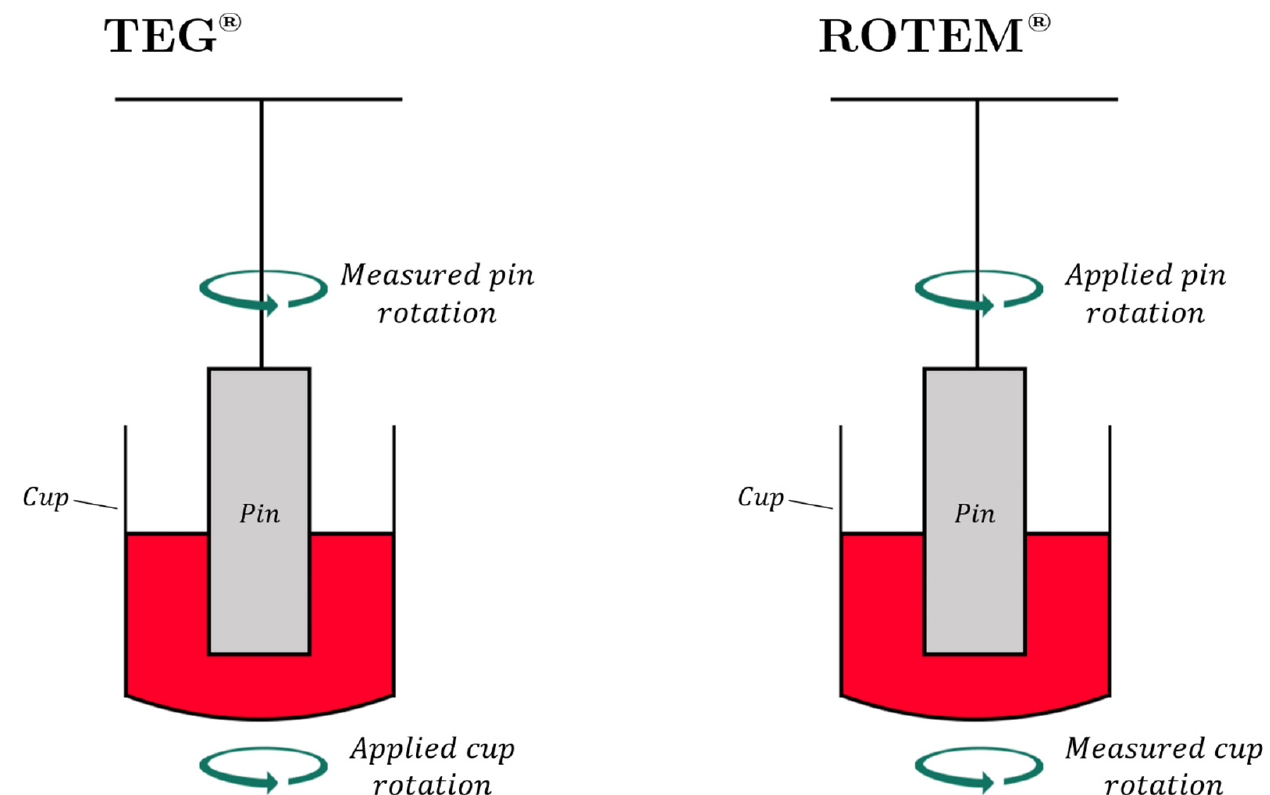
Figure 1. The TEG ® and ROTEM ® analyzers are each composed of a cup containing a whole blood sample, a pin suspended in the blood sample, a torsion wire, and a transducer. The cup is rotated at a speed of 4.45 ◦ per 10 s in TEG ® . In ROTEM ® , the pin is instead rotated, at the same speed of 4.45 ◦ per 10 s. In both assays, clotting of the whole blood gradually synchronizes the rotations of the cup and pin, which causes a change in torque on the torsion wire that is measured by the transducer. Various coagulation activators may be used depending on the assay. Intrinsic coagulation activators include kaolin or ellagic acid; extrinsic activation most commonly uses tissue factor [43,106,107].